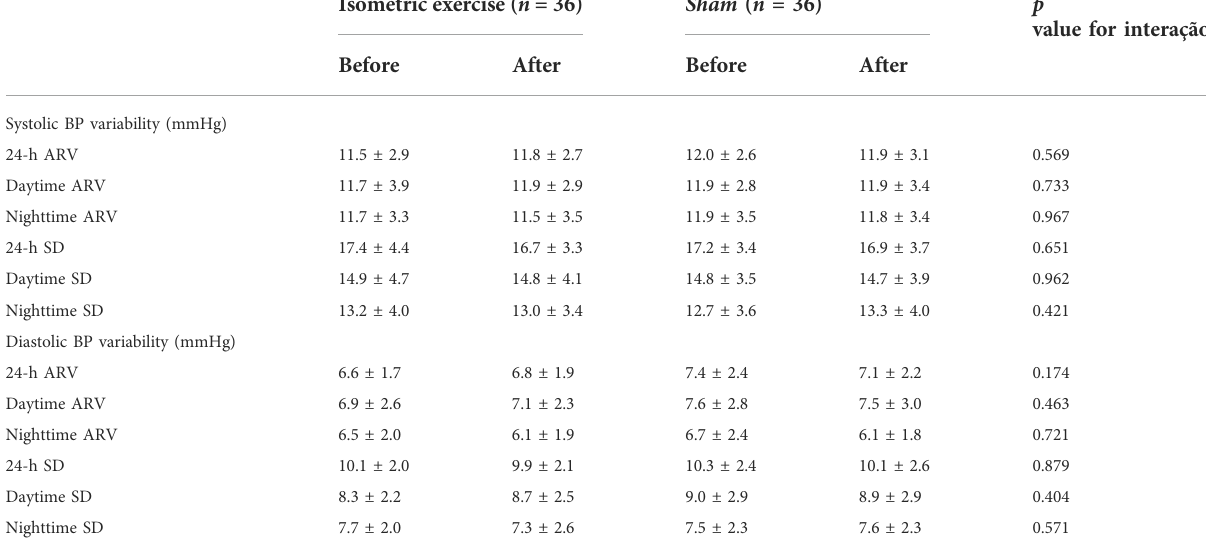
TABLE 3 Short-term variability assessed through ARV and SD for Systolic and Diastolic blood pressure obtained at the 24-h ABPM.